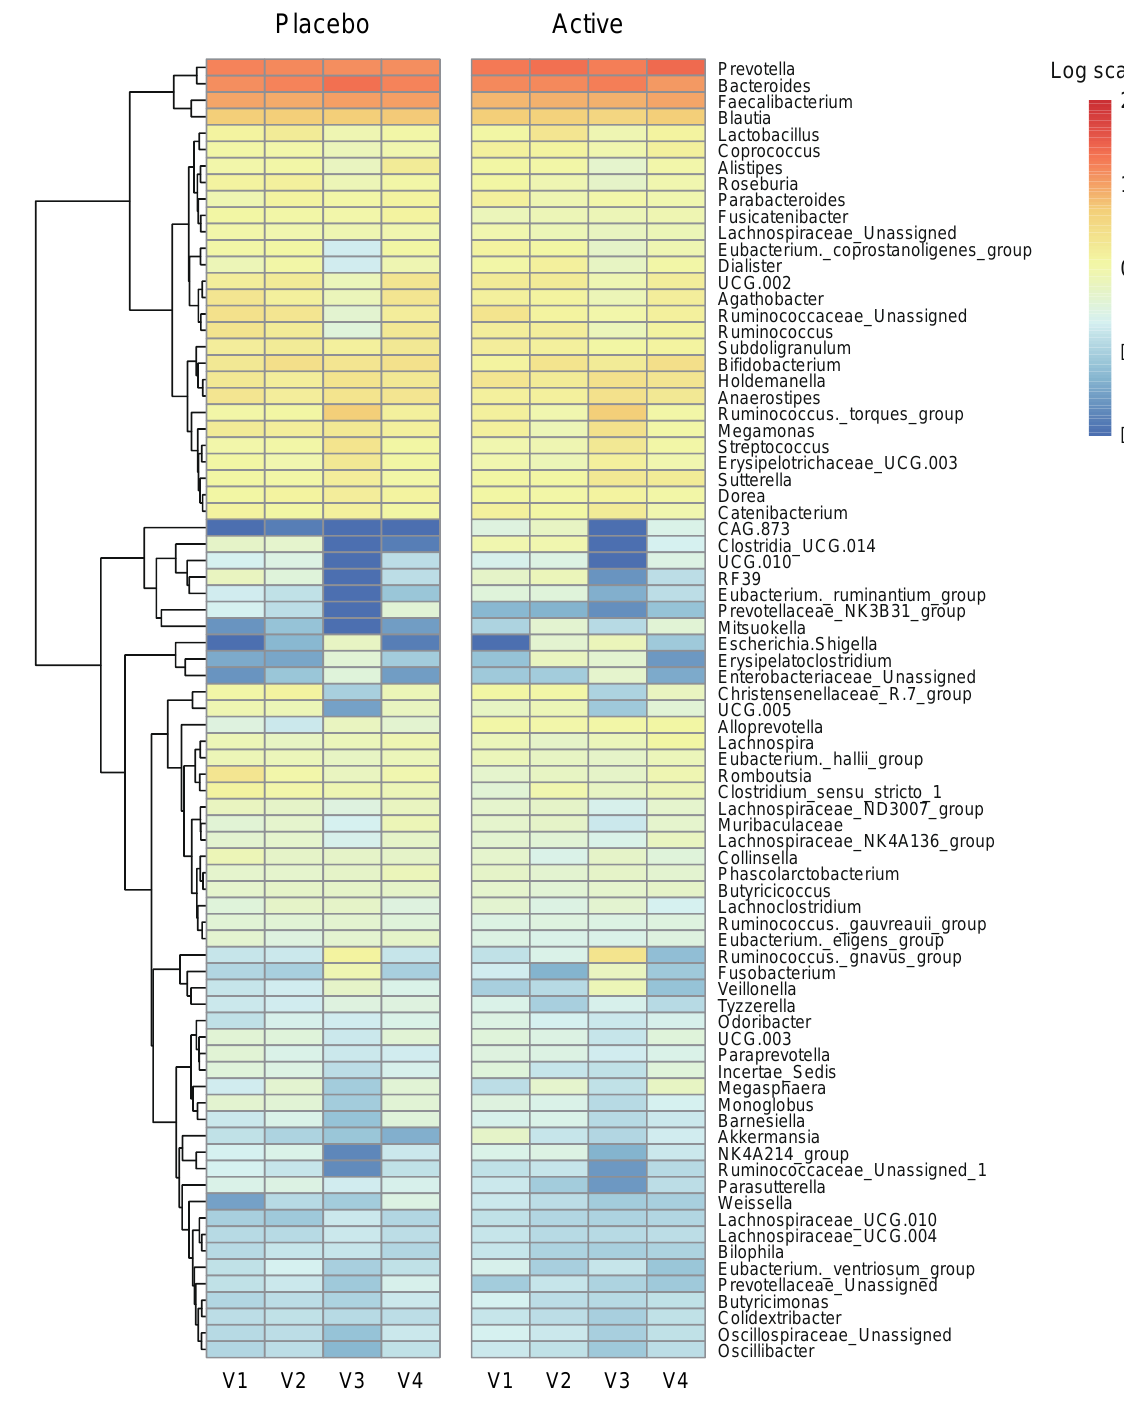
Figure 4. Heatmap analysis via relative abundance at the genus level. Heatmap on relative abun- dances of annotated OTUs at the genus level. Genus with an average < 0.01% were excluded. Ranges were applied to the analysis by logarithmic scale. OTUs, operational taxonomic units.